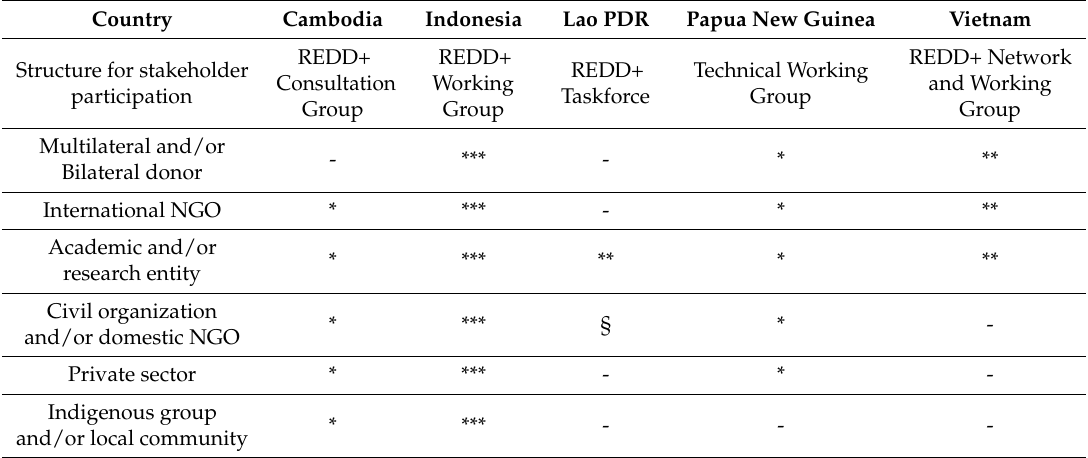
Table 3. Participation of non-state actors in REDD+ institutional arrangements in the five countries in